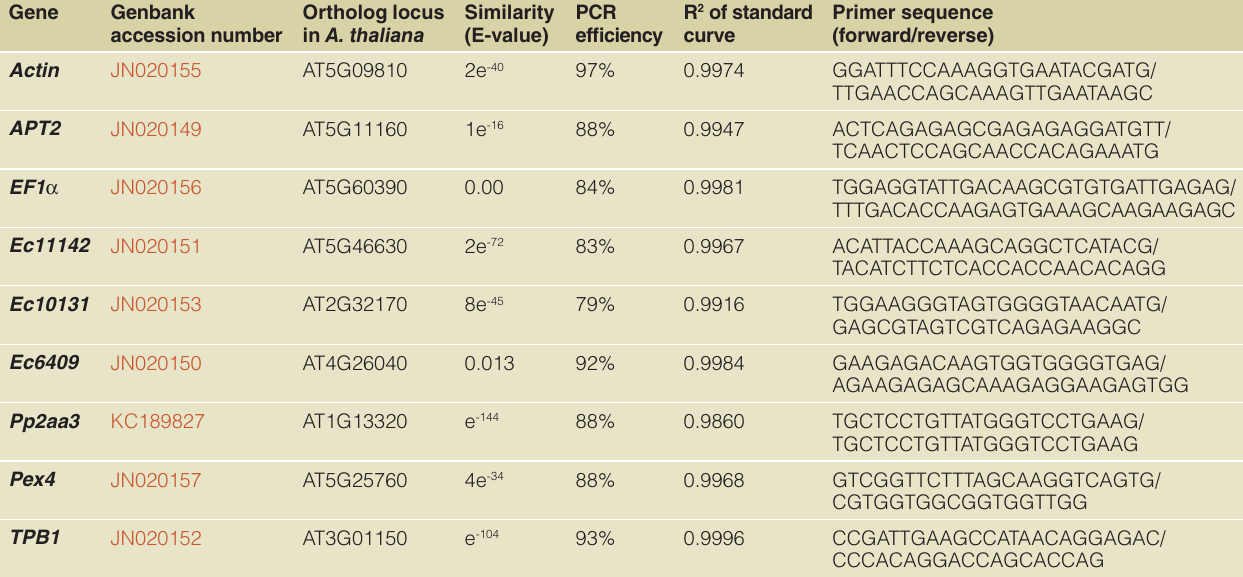
Table 1. Description of Erythroxylum coca candidate reference genes. GenBank accession numbers are given for each gene used in this study. The orthologous locus in A. thaliana is referred to by its AGI (Arabidopsis Genome Intitiative) designation. Similarity values are represented by E-values for the pairwise comparison of the coca gene with its Arabidopsis ortholog. PCR amplification efficiencies and the regression coefficients for their standard curves are reported for each primer pair. Gene Genbank Ortholog locus accession number in A.